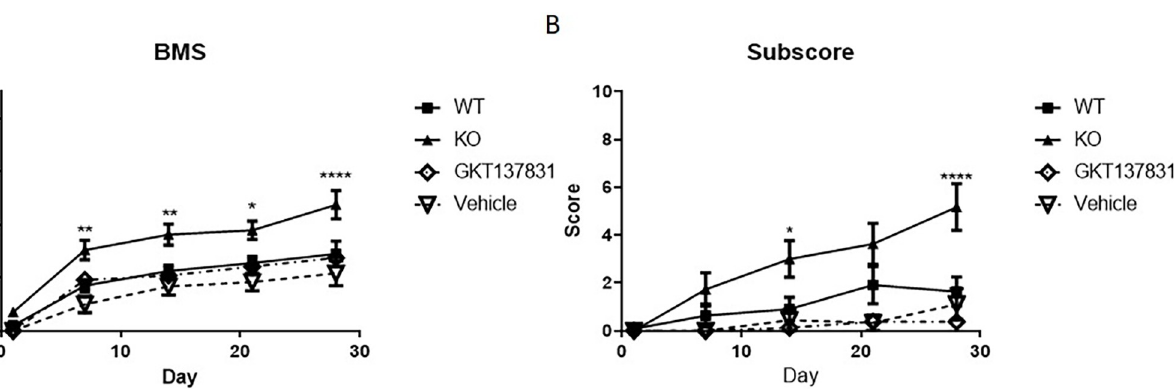
Fig 1. Hind limb locomotion recovery post surgery was measured using Basso Mouse Scale (BMS) at 1, 7, 14, 21, and 28 days post injury. The BMS average score showed significant improvement at 7, 14, 21 and 28 days in NOX2 KO injured mice compared to wild type injured mice (A). Subscore analysis showed significant improvement at 28 days post-injury in the KO group (B). Points represent mean +/- SEM., NOX2 KO injured n = 12, WT injured n = 10, Vehicle n = 6, GKT n = 9. � p < 0.05, �� p < 0.01, ���� p < 0.0001 repeated measures ANOVA.